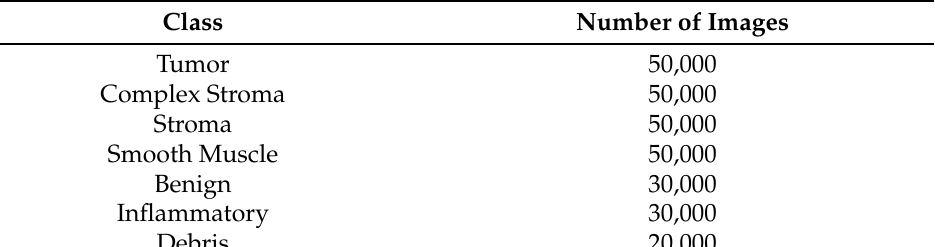
Table 1. CRC-TP database composition.